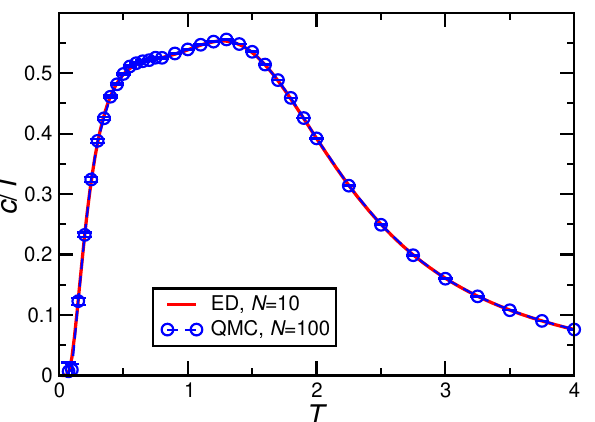
Figure 5. Specific heat per spin c calculated for D = 0.36/2.8, h = 0, J = 1. As in Figure 4, the left panel shows the specific heat itself while the right panel shows the specific heat divided by temperature c / T .